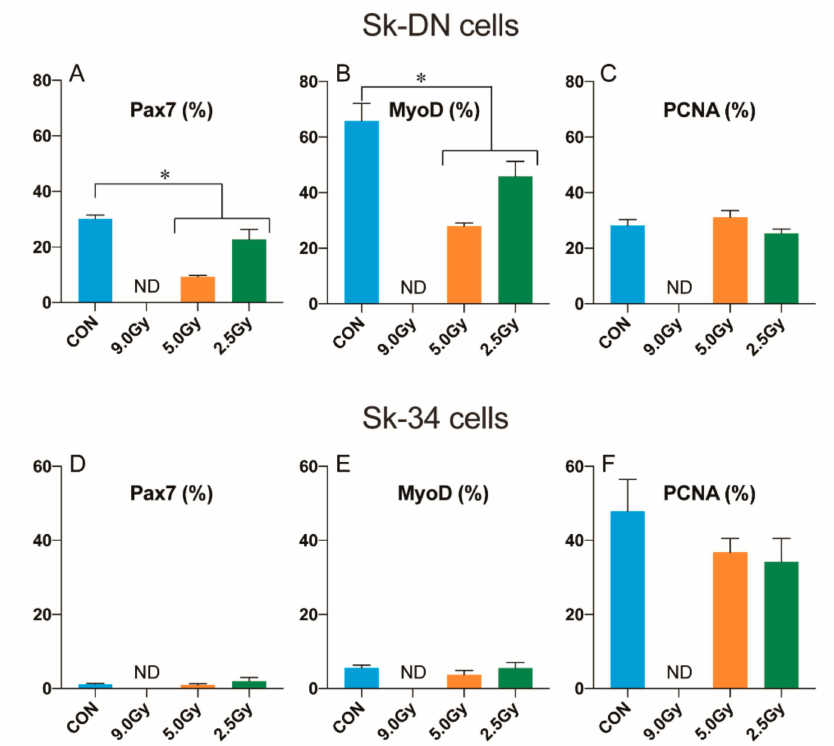
Figure 6. Myogenic differentiation and proliferation capacity in Sk-DN and Sk-34 cells isolated from normal and TBI muscles. Cells were sorted as CD45-/34-/29+ fraction (( A – C ), Sk-DN) and CD45-/34+ group (( D – F ), Sk-34), and cultured for 5 days. Myogenic differentiation capacity was examined by Pax7 and MyoD expression, and cellular proliferation capacity was determined by PCNA expression. Values were calculated as the percentage of positive cells/total cells, and expressed as mean ± S.E. * p <